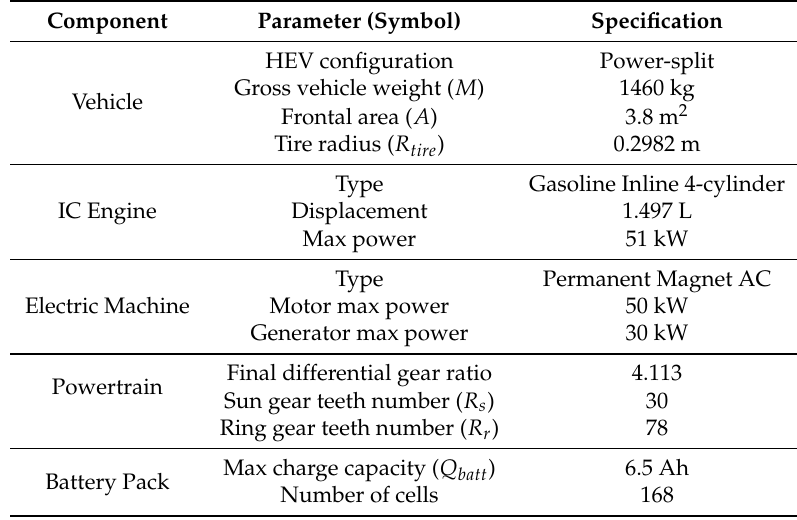
Table 1. PHEV model